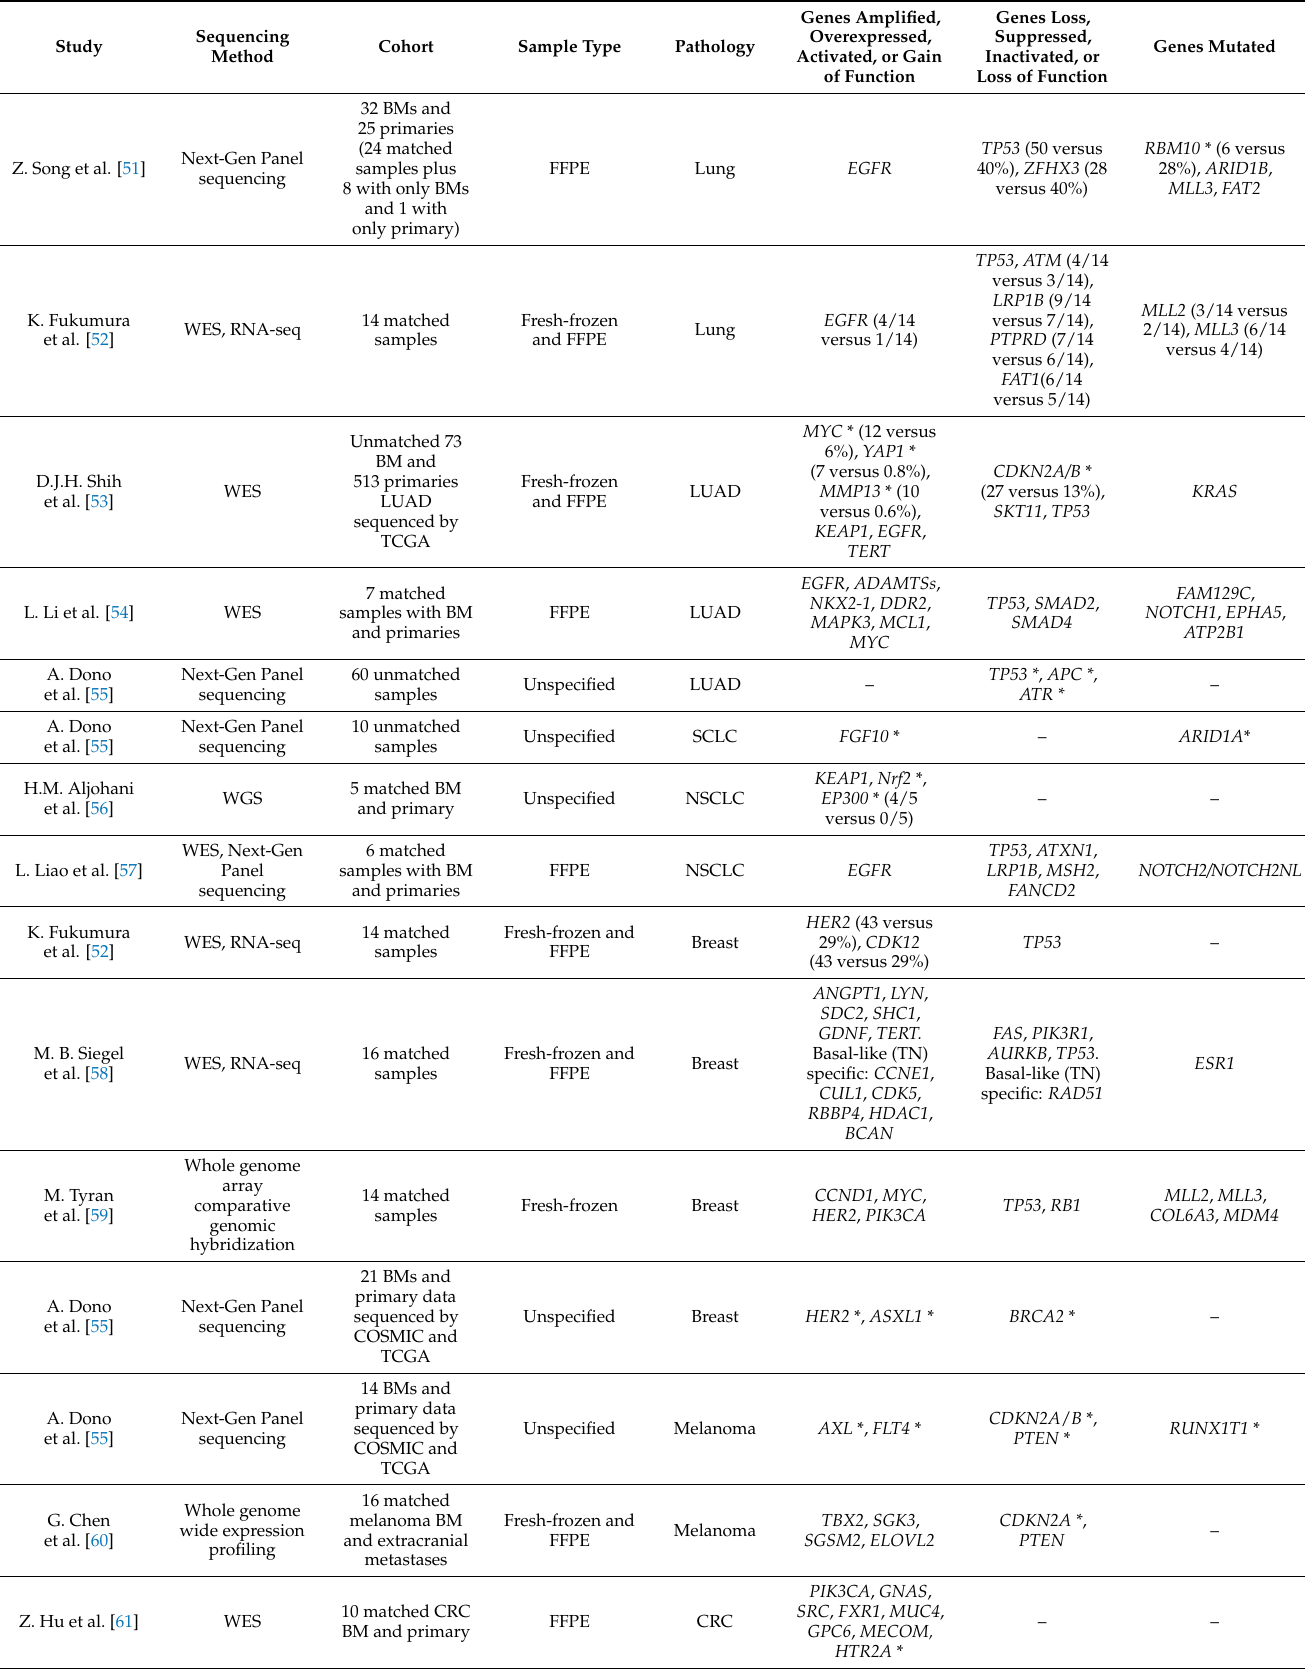
Table 1. Genomic alterations and potential drivers in BM from different primary